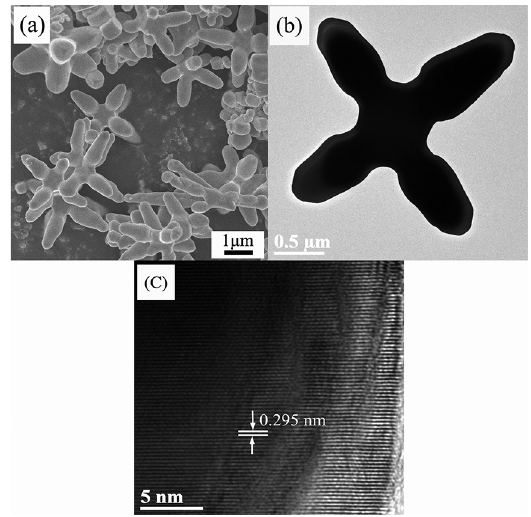
Figure 2: (a) SEM, (b) TEM, and (c) HRTEM images of PbS.